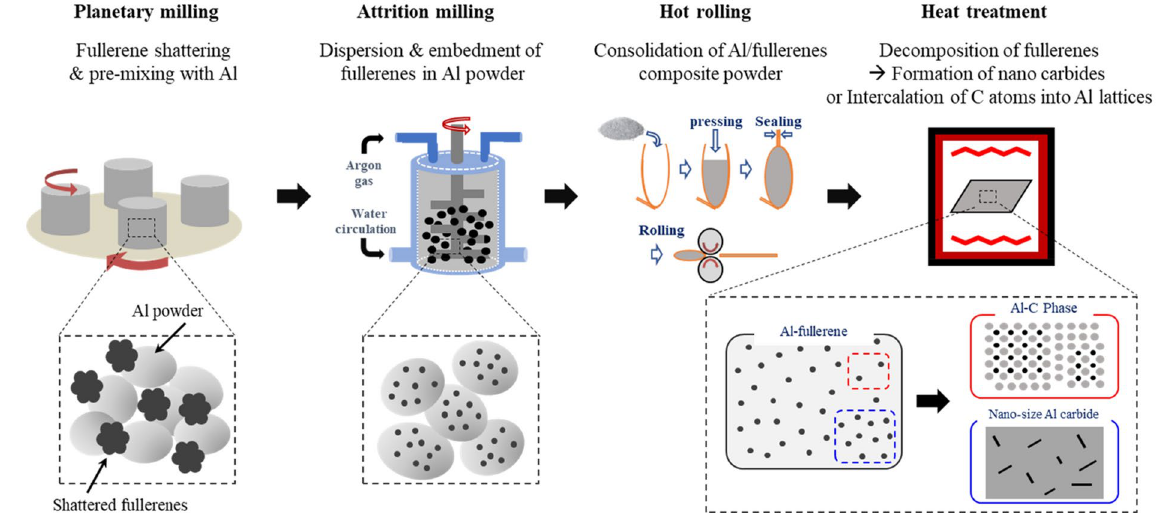
Figure 2. Schematic showing experimental procedure of Al-C nanocomposites.